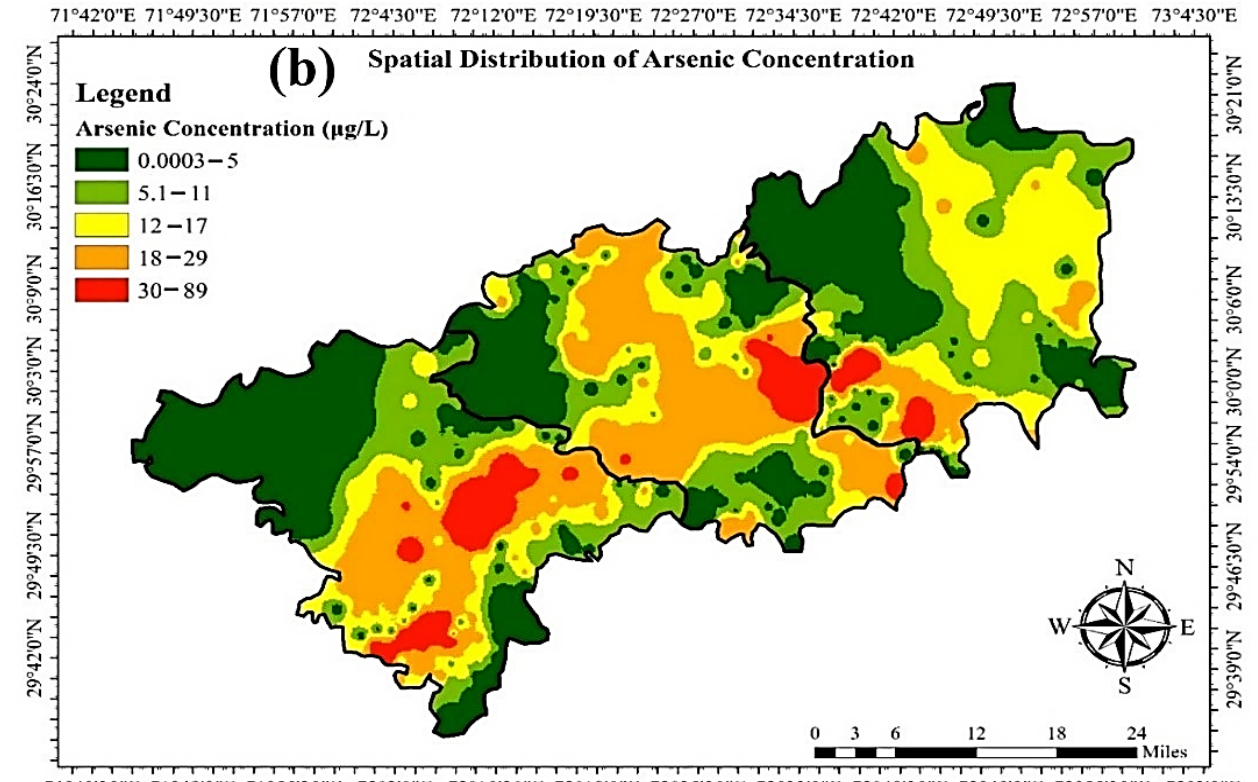
Figure 5. ( a ) Sources of As mobilization. ( b ) Spatial distribution of groundwater As in study area.